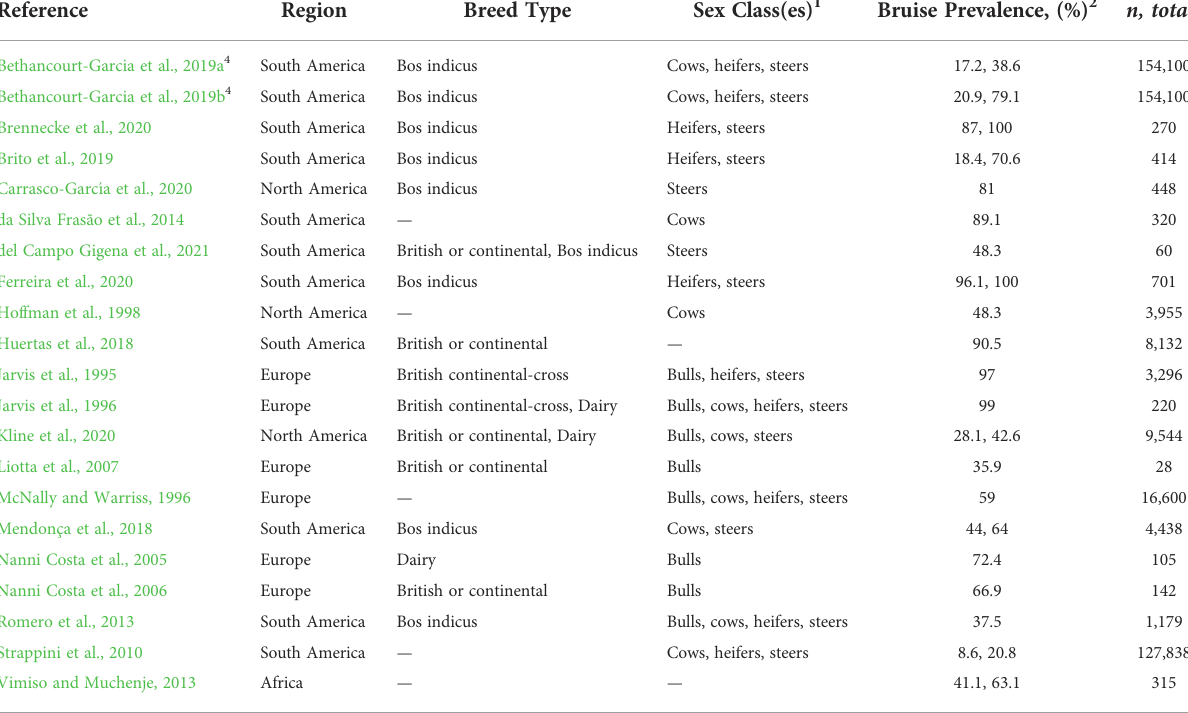
TABLE 2 Bruise prevalence by region, breed type, and sex class ( n =